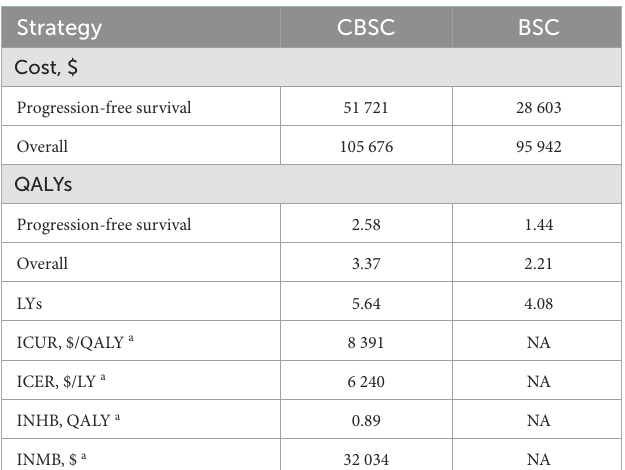
TABLE 2 Baseline